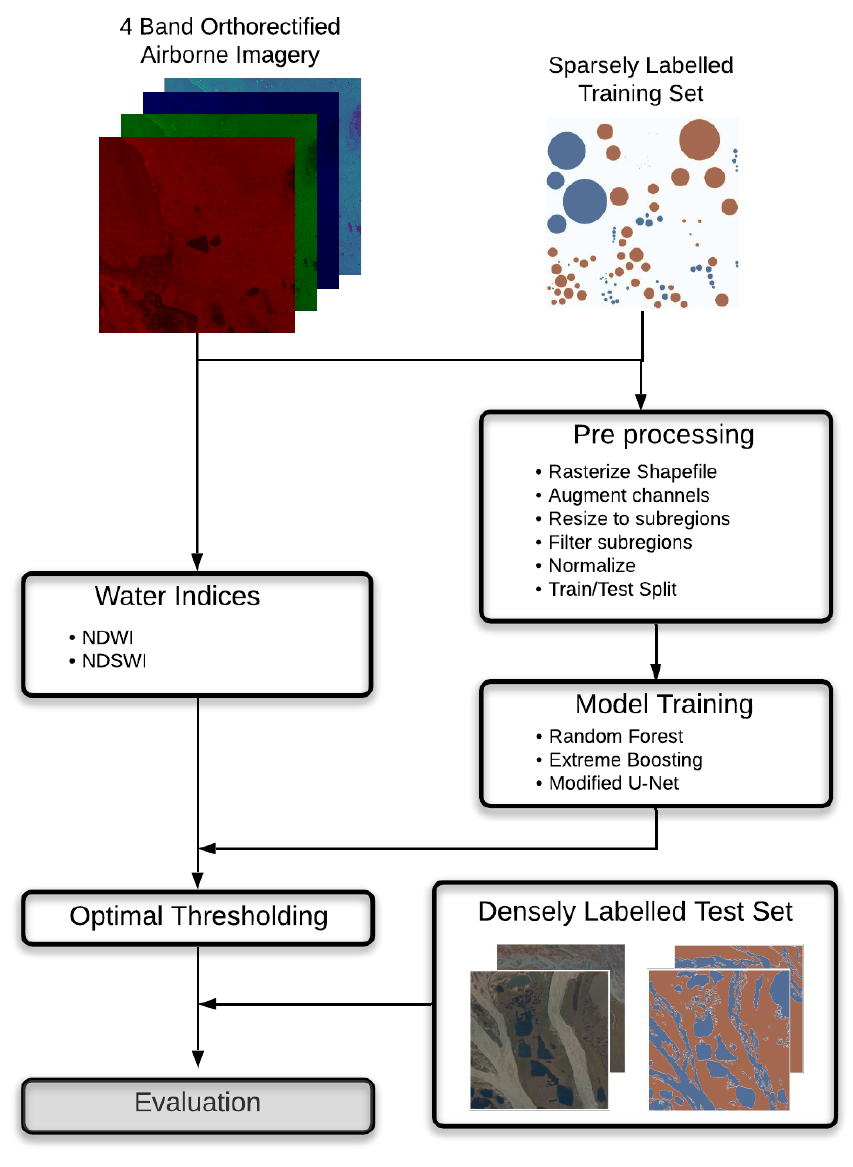
Figure 5. Our methodological pipeline takes in airborne imagery and its corresponding sparsely labelled shapefile to prepare subregions for training and